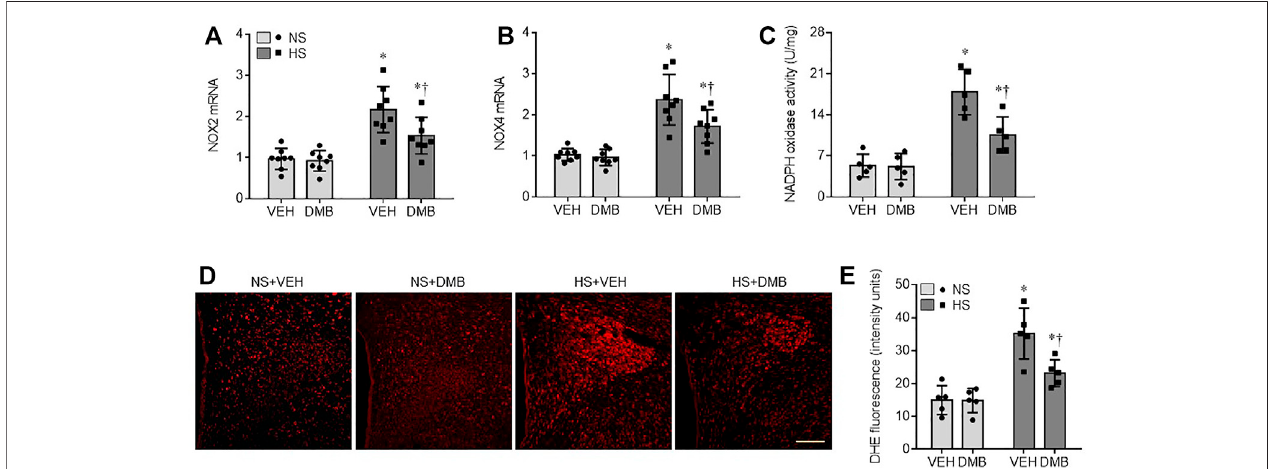
FIGURE5| mRNAexpressionofNAD(P)HoxidaseisoformsNOX2 (A) andNOX4 (B) ,NAD(P)Hoxidaseactivity (C) ,andreactiveoxygenspecies(ROS)production (E) asmeasuredbyDHEstaininginthePVN inratsfedanormal salt(NS) dietorahigh salt(HS) dietand simultaneouslytreatedwithvehicle (VEH)or1.0% 3,3-Dimethyl- 1-butanol(DMB,aninhibitoroftrimethylamineformation).RepresentativeimagesfromeachgroupshowingDHE fl uorescencearepresentedin (D) .Scalebar=100 μ m. All data are expressed as mean ± SEM ( n = 5-8 rats/per group). p p < 0.05 vs . NS + VEH; † p < 0.05, HS + DMB vs . HS + VEH.